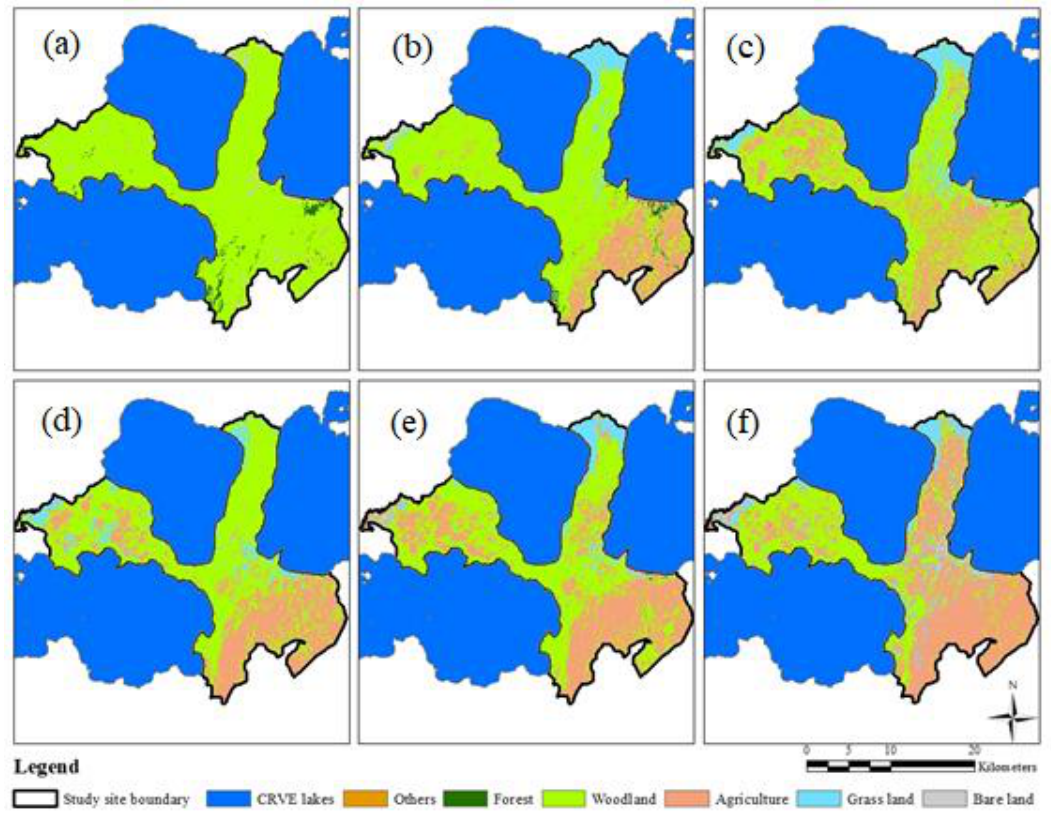
Figure 2. Land cover of the study area in ( a ) 1973, ( b ) 1986, ( c ) 2000, ( d ) 2005, ( e ) 2011 and ( f ) 2013. Table 4. Area in hectare and the percentage of the land cover of each class in each reference year.